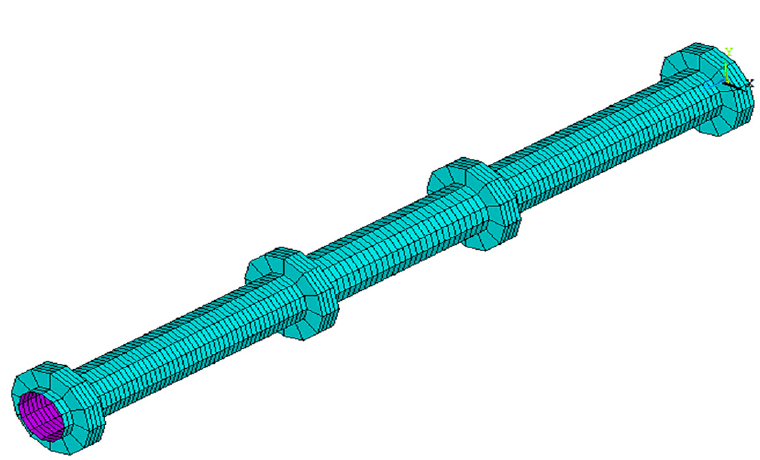
Figure 7. The merge of the circular hollow specimens and